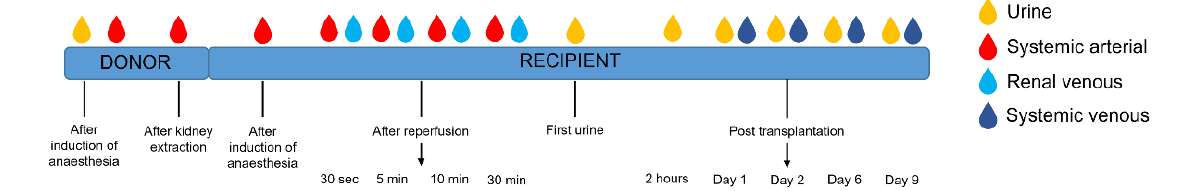
Figure 2. Timeline sample collection in donor and recipient.